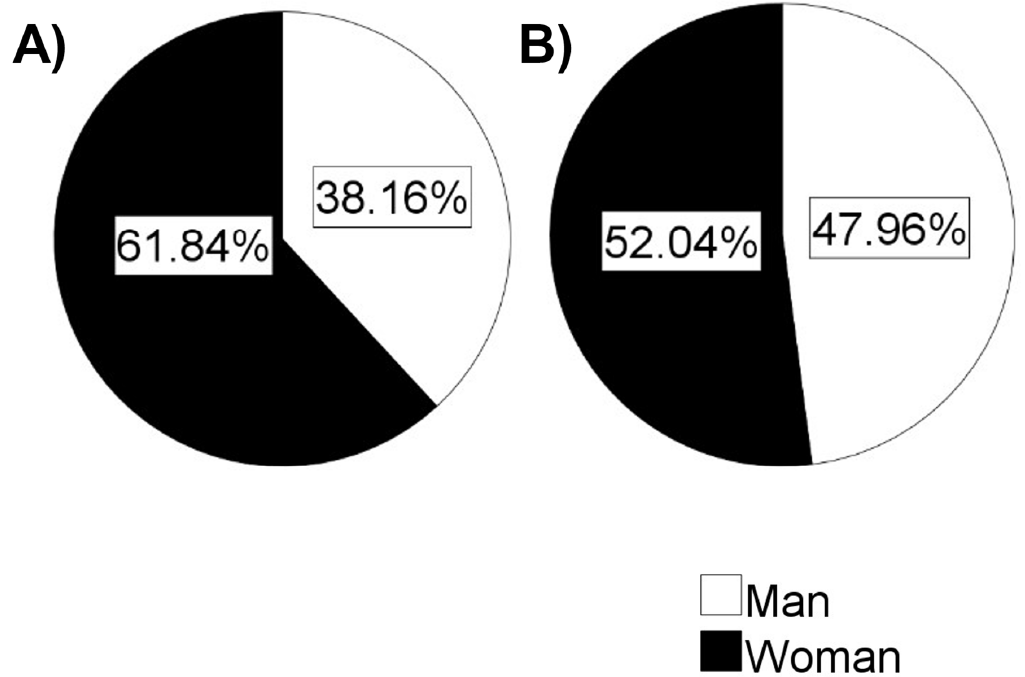
Figure 3. Authorship distribution. Authorship was inferred by allocation of first names, as well as web searches for identification in CV, institutional pages or social media. Authorship is reported for first ( A ) and last ( B )